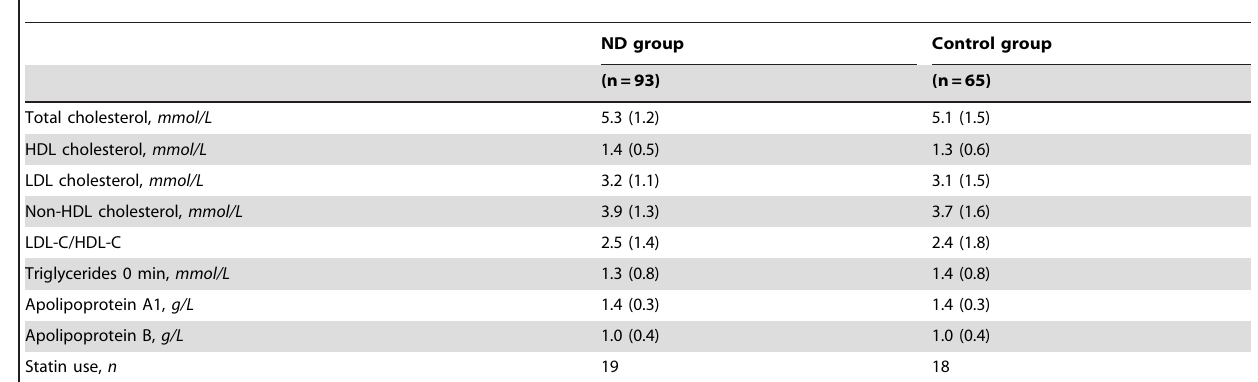
Table 1. Baseline blood lipid concentrations and statin use of the